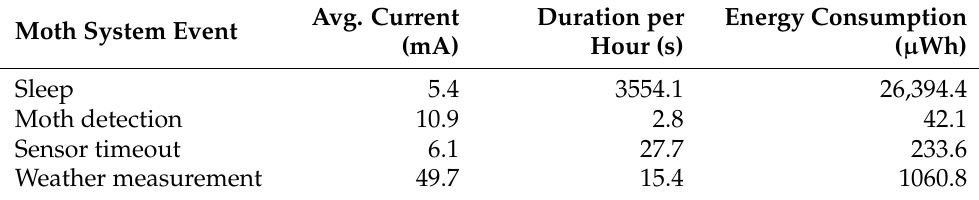
Table 4. Moth system events energy consumption characterization.